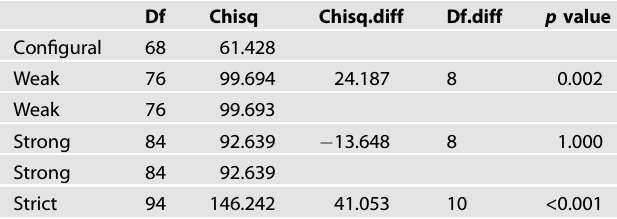
Table 2. Con fi rmatory factor analysis